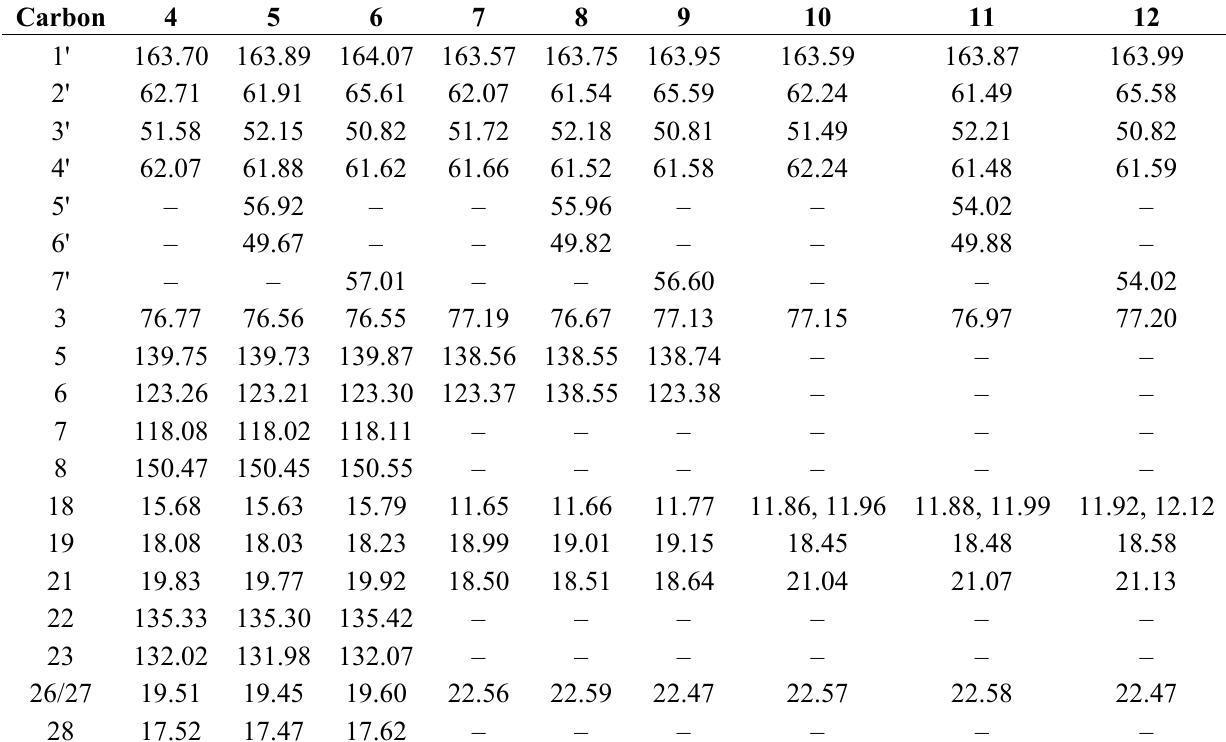
Table 2. Heat of formation (HOF) [kcal/mol] of sterols ( 1 – 3 ) and their conjugates 4 – 12 .